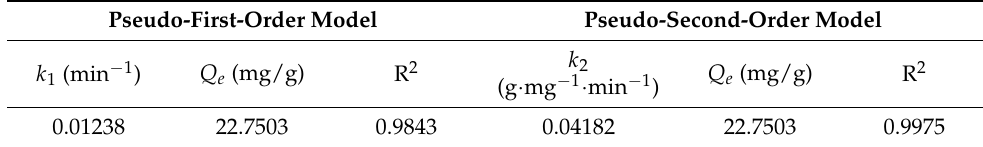
Table 3. Kinetic parameters of model fitting for adsorption of NB by cellulose-St.